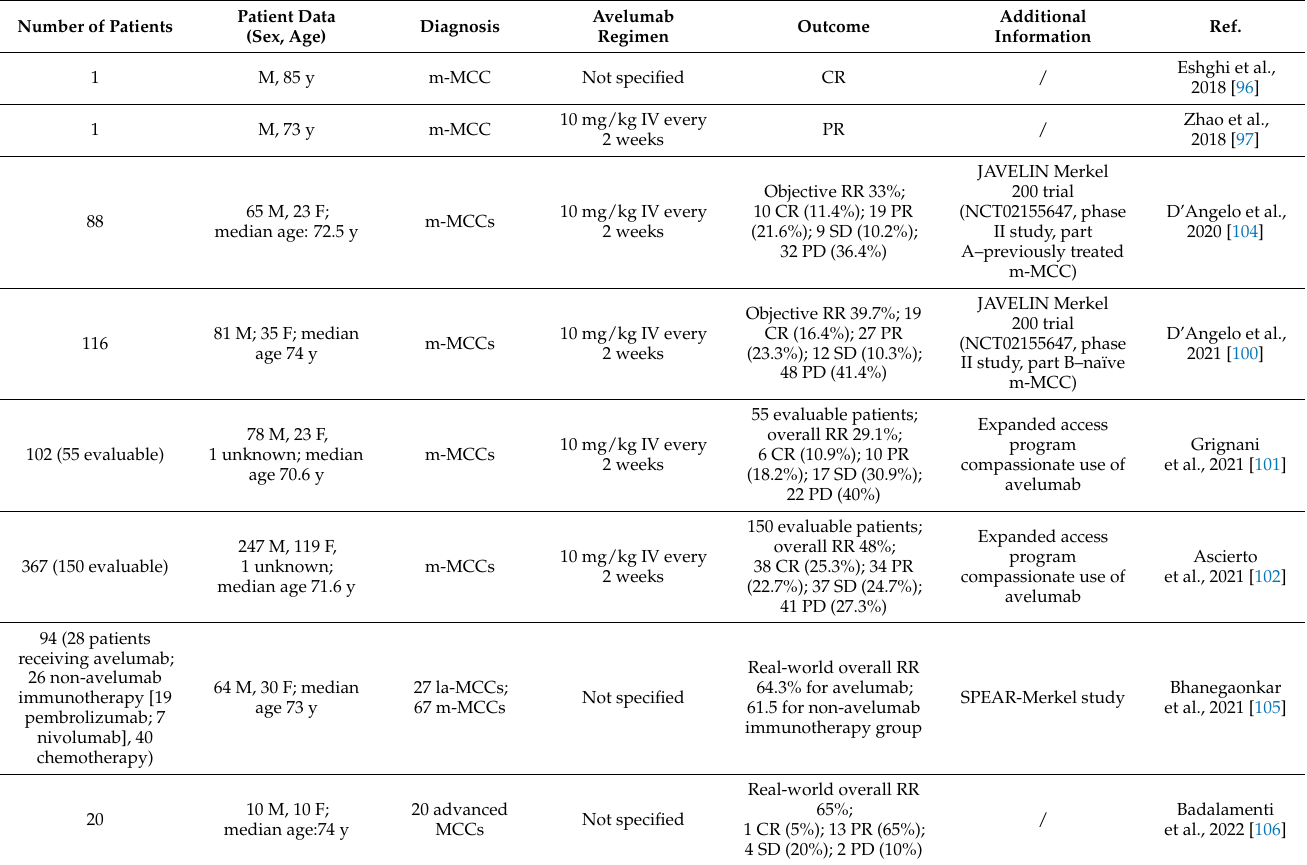
Table 5. Reported cases of locally advanced and metastatic Merkel cell carcinomas treated with